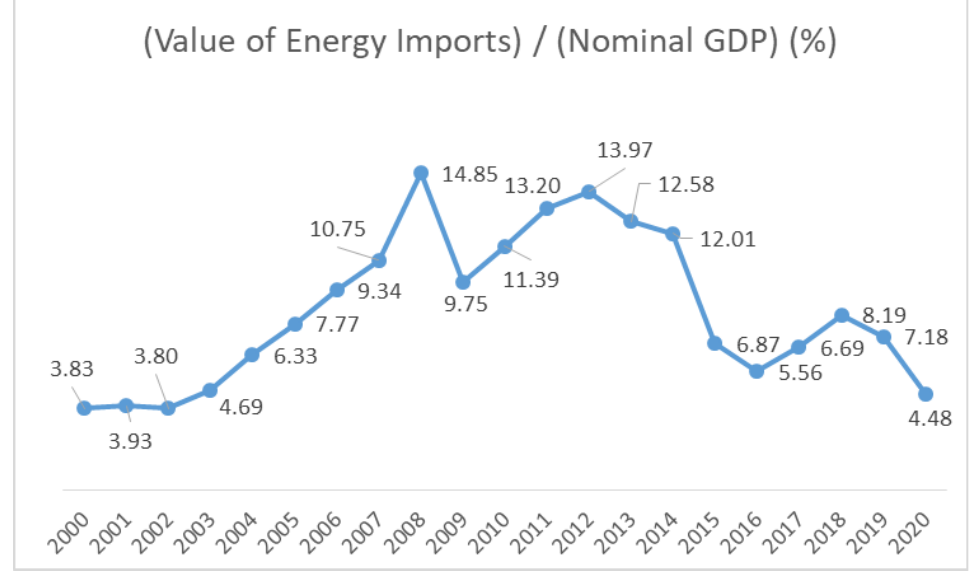
Figure 8. Value of energy imports/nominal GDP in Taiwan for 2000 – 2020. Source: Bureau of Energy, MOEA.